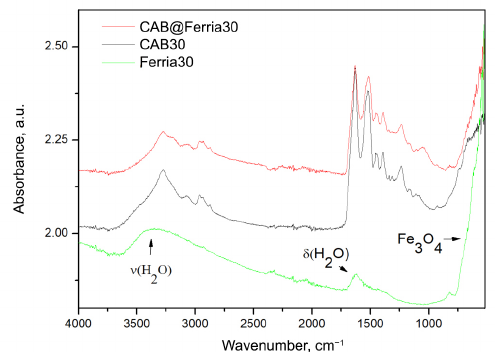
Figure 3. ATR converted to absorbance spectra of CAB@Ferria, CAB and Ferria at 30 ◦ C. The bands on Ferria spectra are assigned are marked with